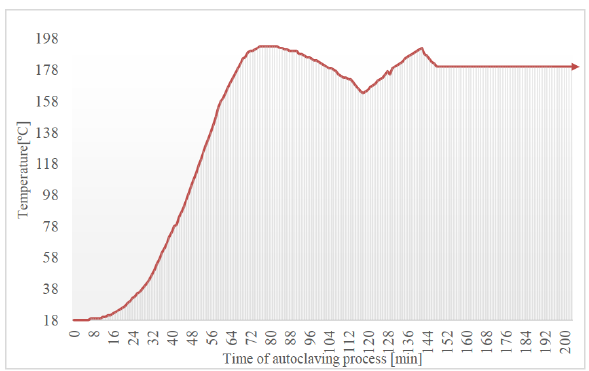
Figure 5: Results of compressive strength and absorbability of sand-lime products with the share of used casting compounds.